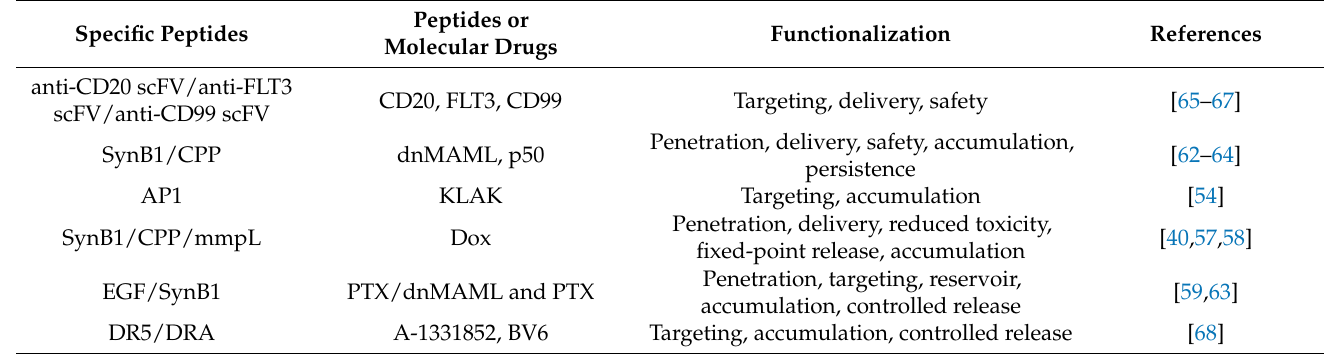
Table 1. Fusion methods of ELPs with specific